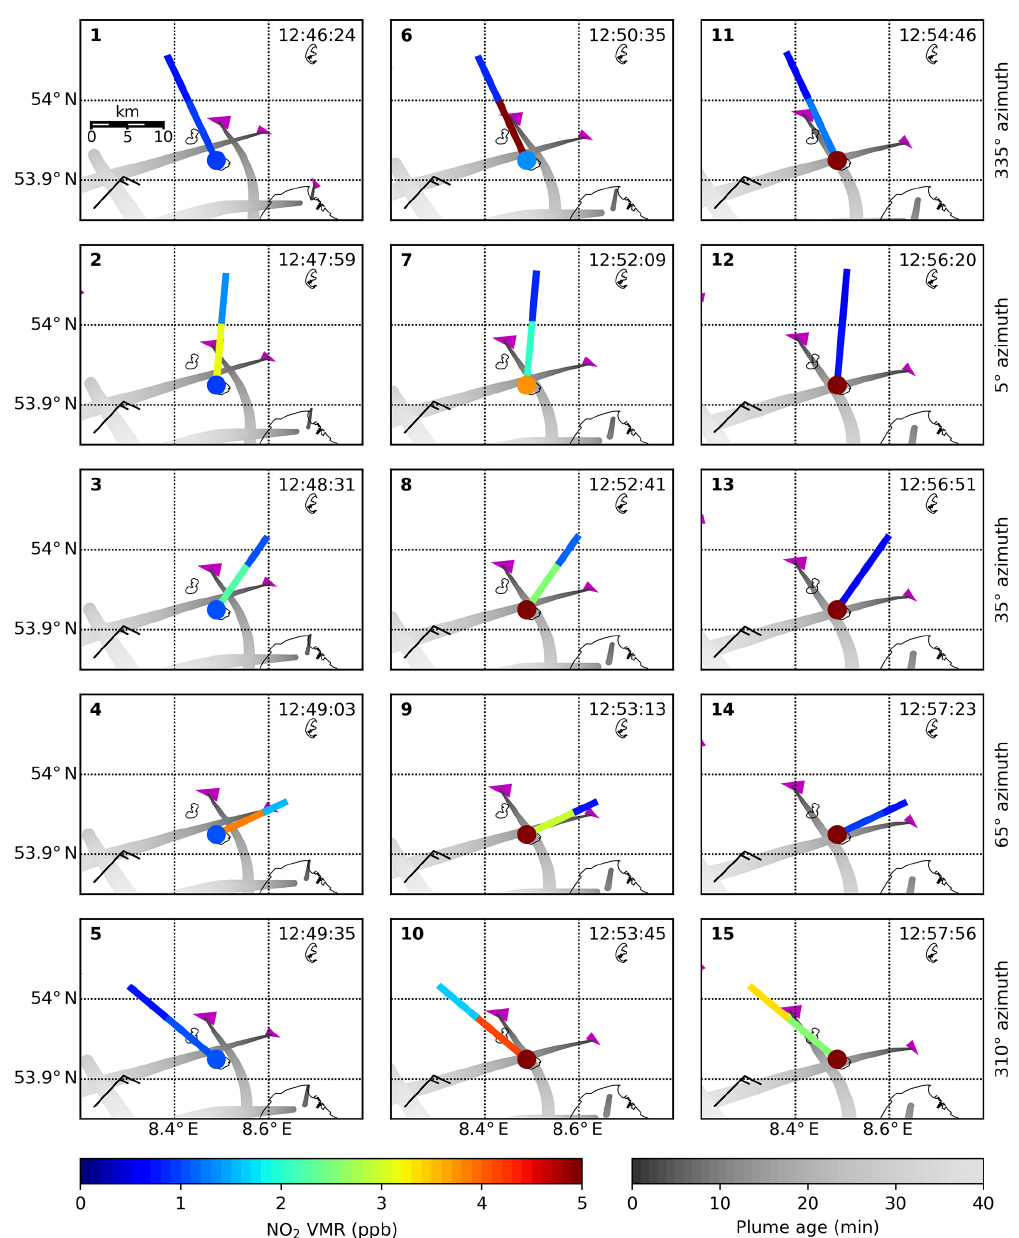
Figure 4. Sequence of maps showing 15 consecutive measurements in 0.5 ◦ elevation on 26 May 2014, starting at 12:46UTC (14:46LT): the extent of the UV path and (cid:49)L and corresponding path-averaged NO 2 VMRs are shown as colored lines. In situ NO 2 VMRs are shown as a colored dot at the location of the measurement site. Magenta triangles show the ship position and course (sharp tip), with larger triangles for larger ships. The modeled plumes are shown in gray, with the lightness of the gray shading representing the plume age. Wind direction and speed are shown with meteorological wind